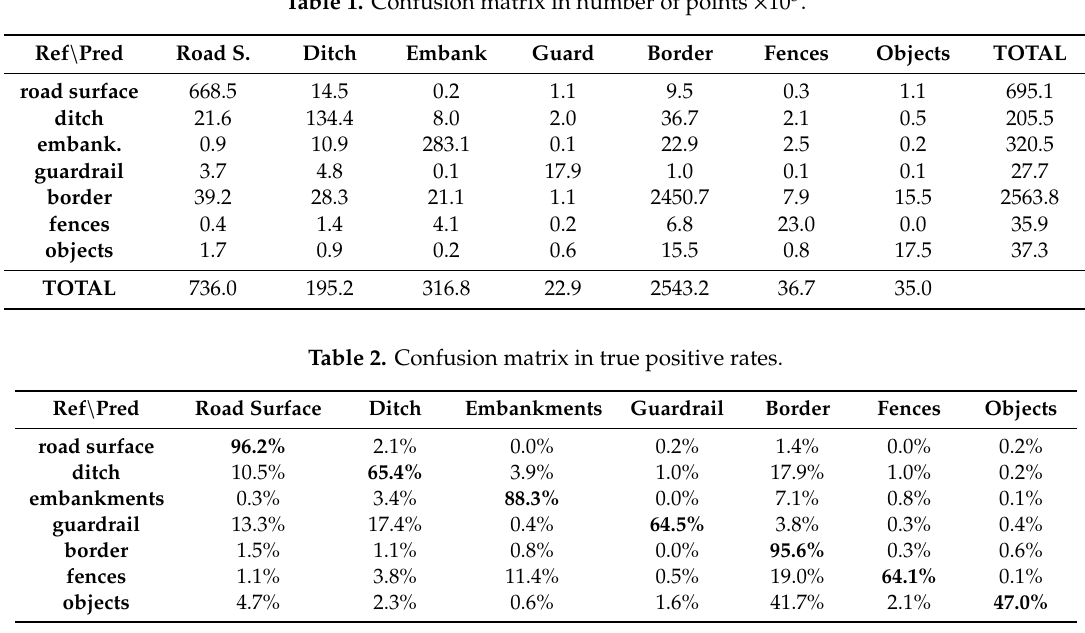
Table 1. Confusion matrix in number of points × 10 5 .